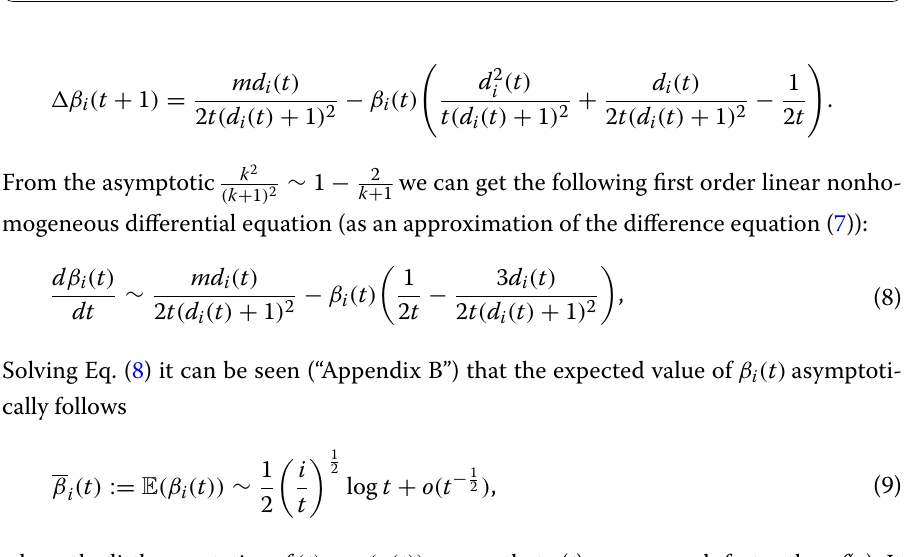
Fig. 6 Empirical trajectories of the values of β i in networks generated with Barabási–Albert model for selected nodes v i , i = 10,50,100,1000 , as t iterates up to 25000. Network in the figure a is modeled with m = 3 , while b is simulated with m =